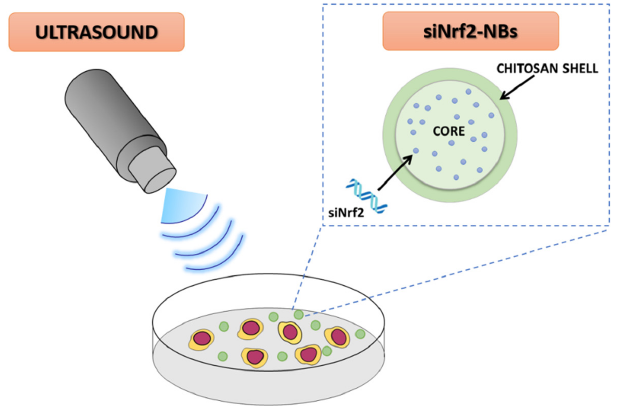
Figure 1. Schematic representation of the ultrasound-responsive Nrf2-targeting siRNA-loaded nanobubbles (siNrf2-NBs). Table 1. Physicochemical parameters of the siRNA-loaded NBs.